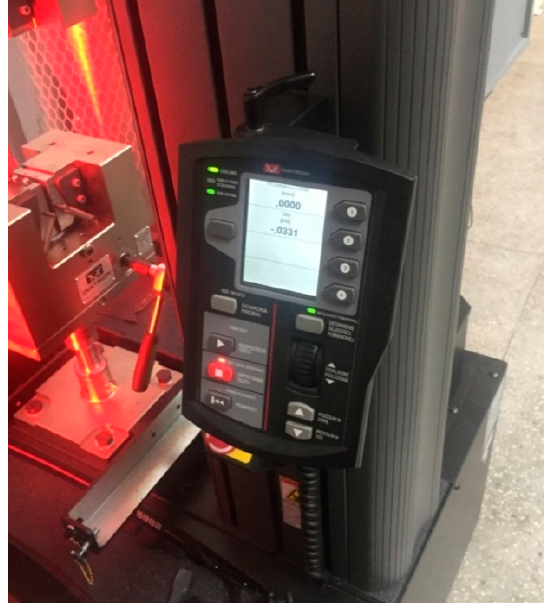
Figure 12. An example of setting the force parameters during the tensile test.